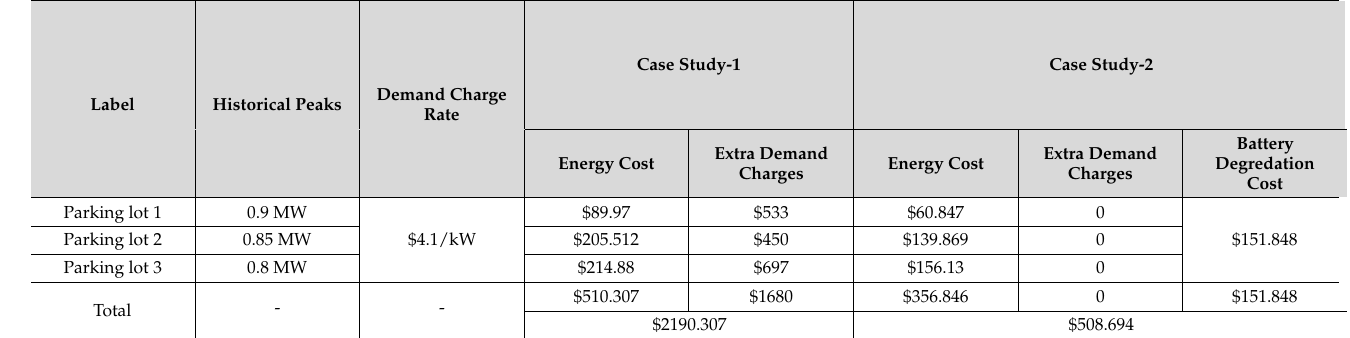
Table 3. Summary of simulation